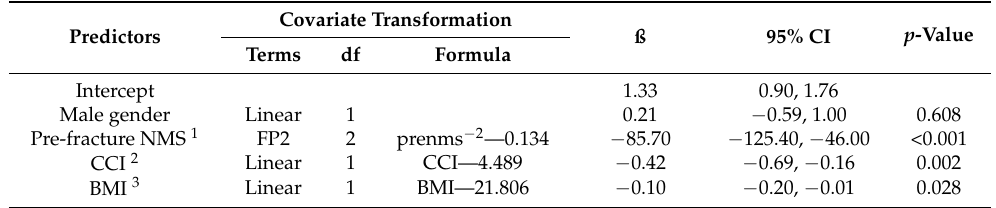
Table 2. Multivariable fractional polynomial logistic regression model for predicting 1-year postoper- ative ambulatory status using patient’s baseline